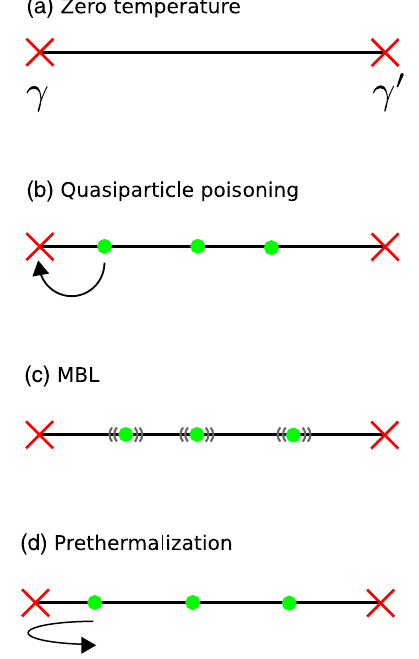
FIG. 1. (a) A 1D chain of a topological superconductor, with Majorana zero modes at the edges. (b) At finite temperature, mobile quasiparticles can annihilate on the Majorana zero modes, decohering the quantum information stored. (c) With strong disorder, the chain can be made to be MBL, such that the localized quasiparticles are not able to annihilate on the boundaries. (d) In a suitable “ prethermal ” regime, the quasipar- ticles are mobile but are prevented from annihilating on the boundary by an approximate conservation